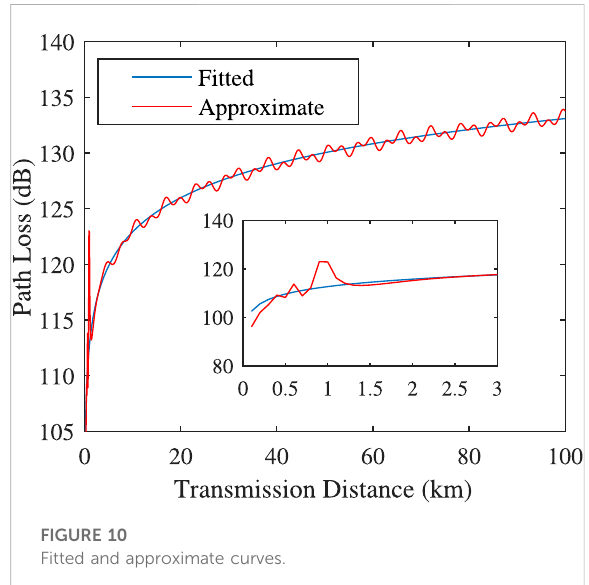
FIGURE 10 Fitted and approximate